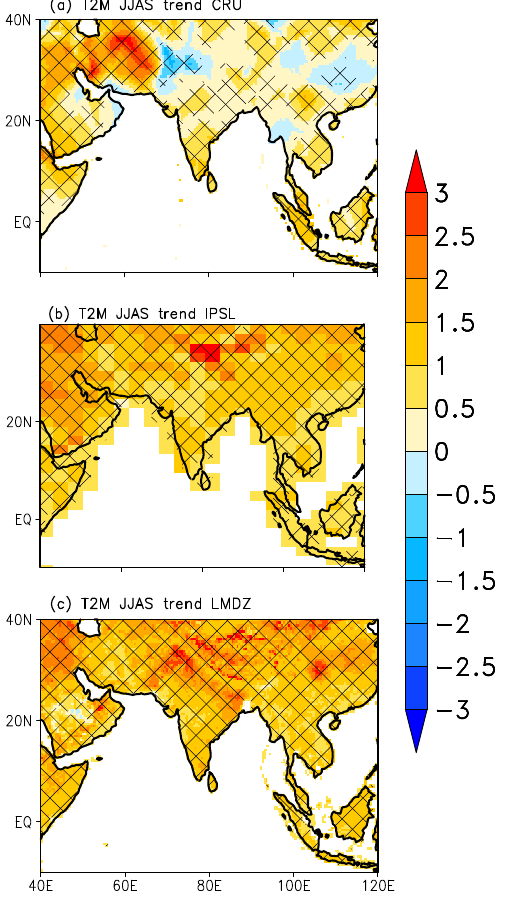
Figure 6. Spatial maps of linear trends in 2m air temperature for JJAS season based on (a) CRU, (b) IPSL and (c) LMDZ HIST sim- ulation. Units are ◦ C change over the period 1951–2005. Trend val- ues exceeding the 95% level of statistical significance based on Stu- dent’s t test are